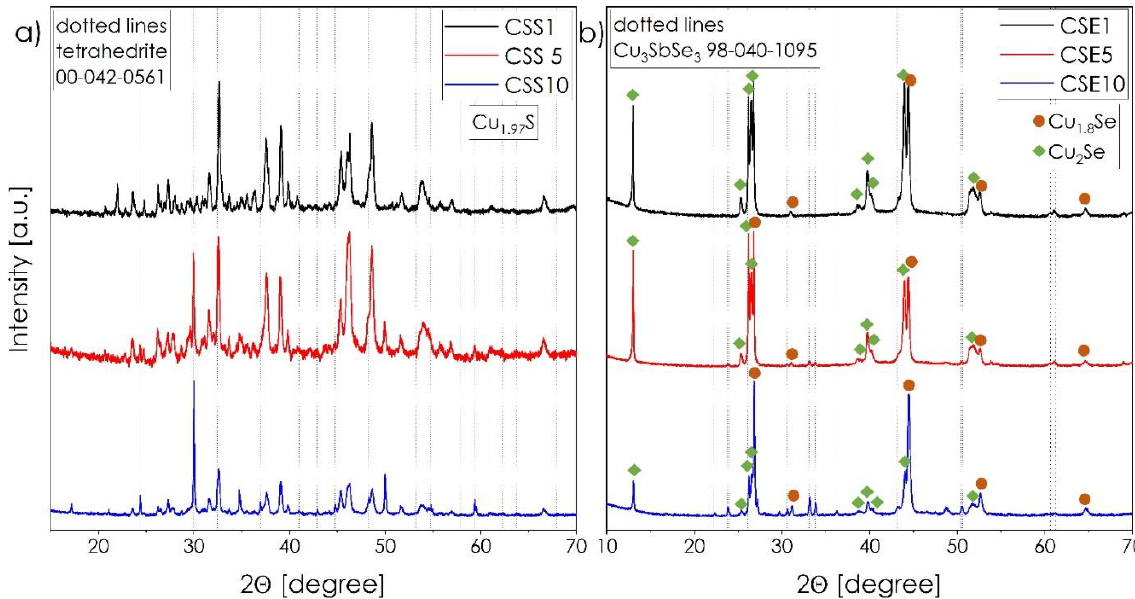
Figure 3. XRD patterns of the Cu 1.97 S–Cu 12 Sb 4 S 13 ( a ) and Cu 2-x Se–Cu 3 SbSe 3 ( b ) composites.